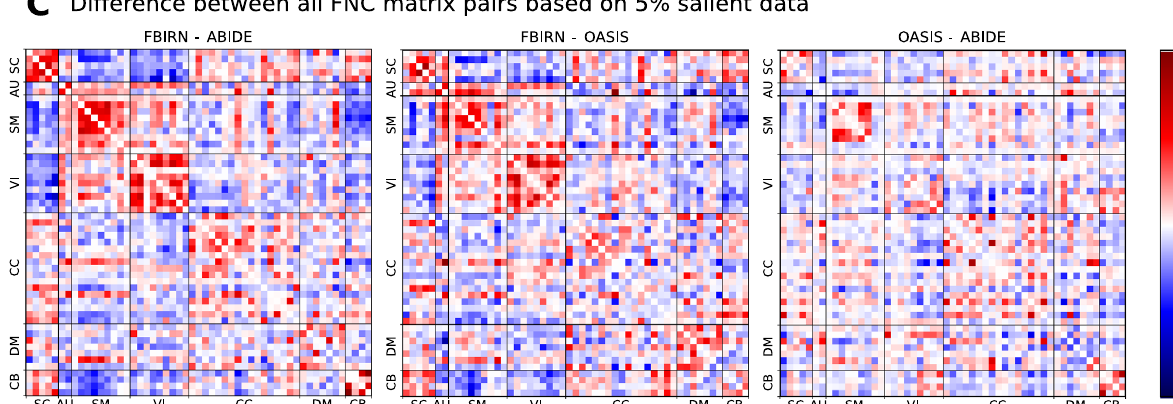
Figure 5. ( A ) Full FNC for patients computed using most 5% of the salient data selected based on feature attribution values for different disorders. ( B ) Static FNC (i.e., using 100% data) matrices for patients of different disorders. The FNC based on 5% salient data ( A ) does indeed convey the same focused dynamic information as currently assessed in FNC matrices based on 100% data ( B ). It is thus apparent that the proposed model can capture the focused information aligned with the current domain knowledge. ( C ) Pairwise difference of FNC matrices based on 5% salient data. The difference FNC matrices based on focused data indicate that each disorder has a uniquely distinguishable association with brain